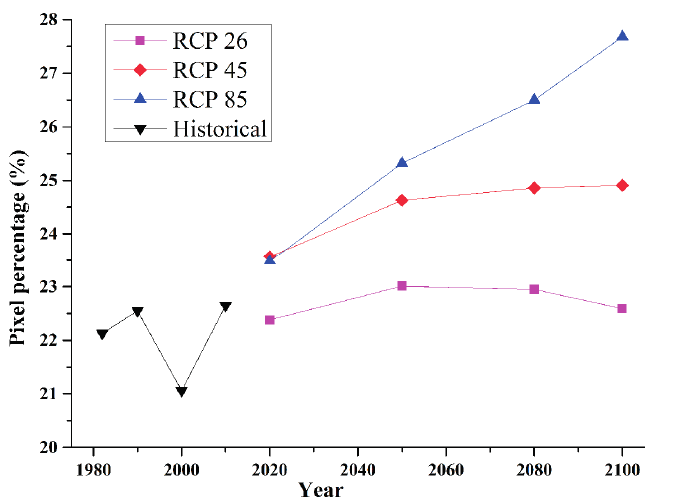
Figure 7. Percentage of desertified area from 1982 to